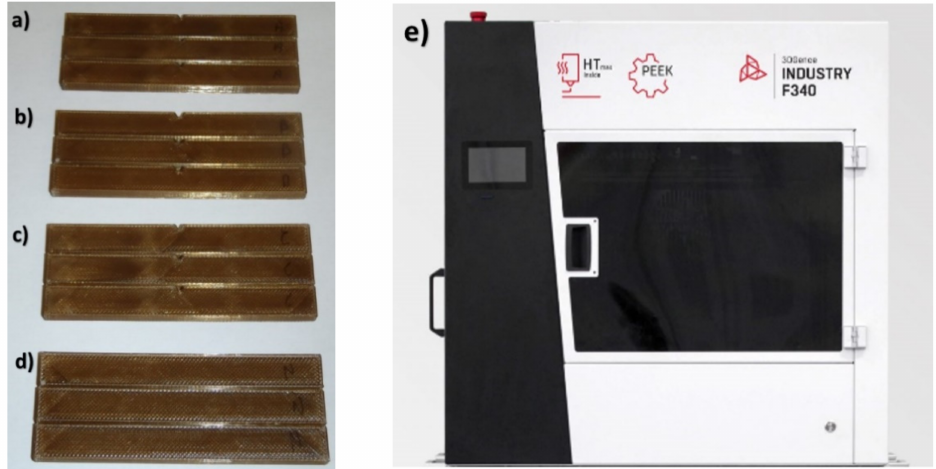
Figure 4. Specimens for impact testing: ( a ) Notch shape type A, ( b ) notch shape type B, ( c ) notch shape type C, ( d ) samples without notches N, ( e ) 3D